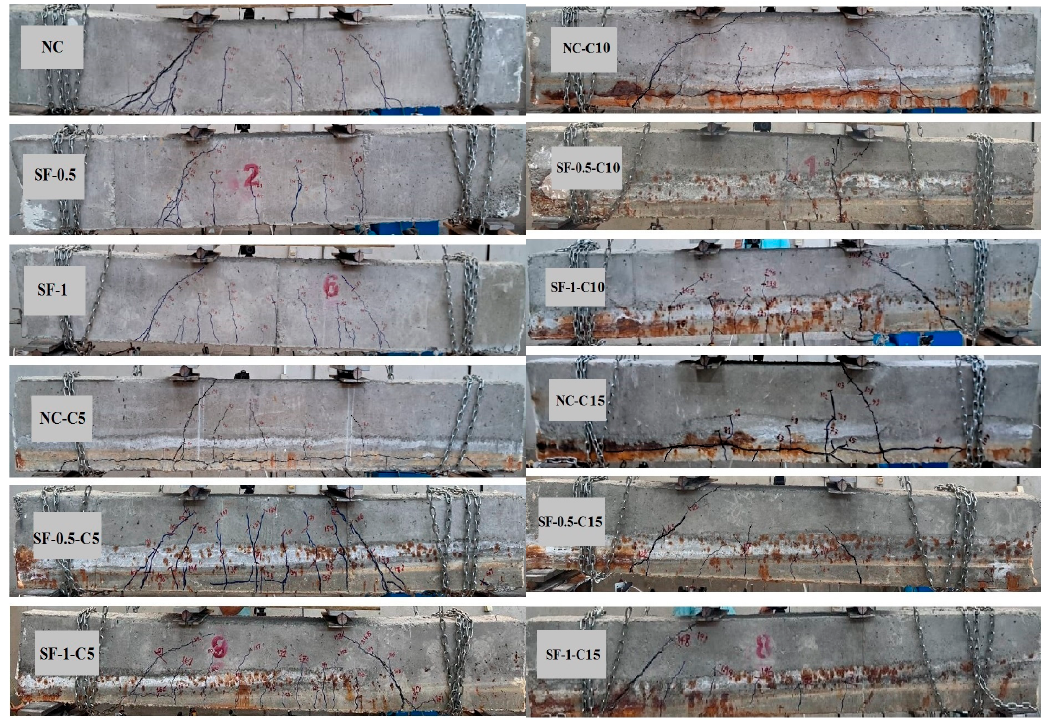
Figure 17. Failure mode and crack pattern of beams.